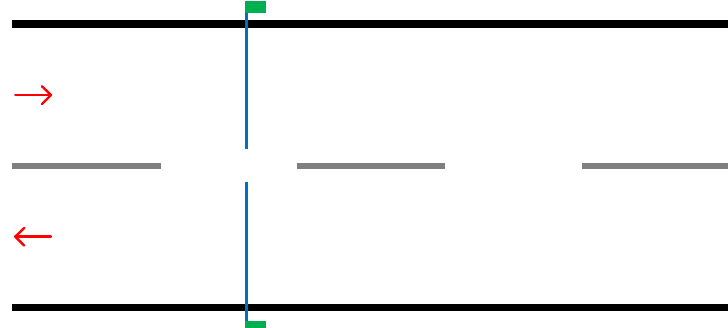
Figure 3. Illustration demonstrating implementation of two piezoelectric sensors. The blue line represents the sensor placed within a groove in the road and the green box representing the counting device.